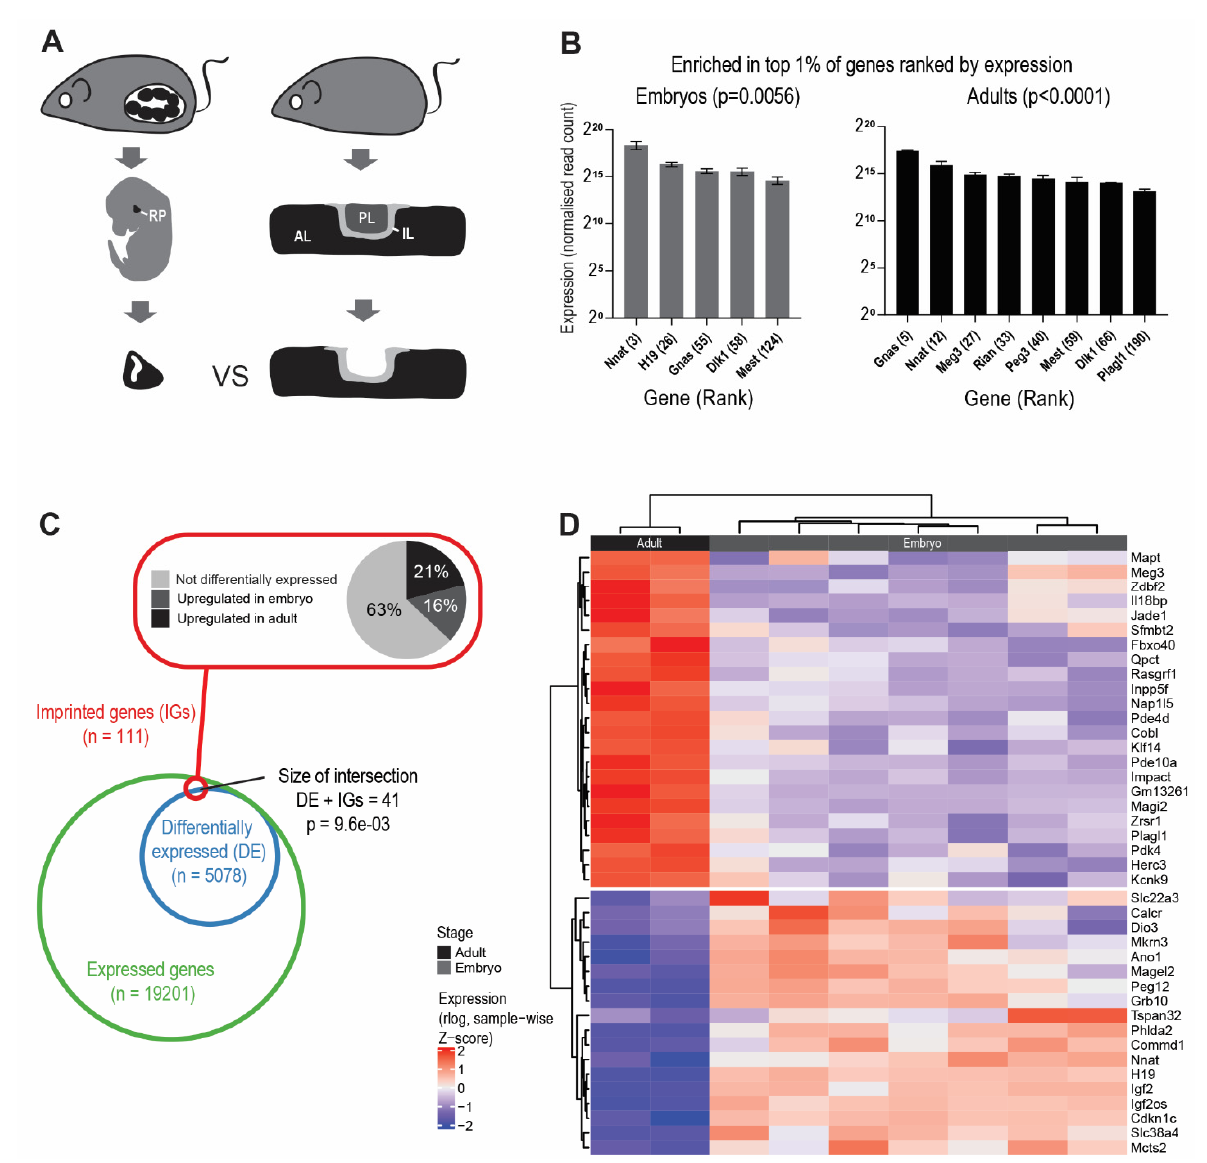
Figure 1. Imprinted genes are highly expressed in the anterior pituitary (AP) and are developmentally regulated. Schema of experimental design: for embryonic samples, Rathke’s pouch (RP) was microdissected from the embryonic heads at e13.5 ( n = 7), adult samples at 8 weeks ( n = 2) were dissected whole, then the posterior lobe (PL) was removed, leaving the anterior lobe (AL) and intermediate lobes (IL) for further analysis ( A ). We ranked genes according to mean normalised read count in the embryonic and adult pituitary samples. Imprinted genes at both ages were enriched in the top 1% of all expressed genes using Fisher’s exact test, and p -values are shown above the graphs ( B ). Venn diagram showing overlap of expressed imprinted genes (red) and differentially expressed genes (blue). The overlap was tested for statistical significance using Fisher’s exact test considering the list of expressed genes (green) as the background ( C ). Heatmap showing imprinted genes, which are differentially expressed between the embryo and adult samples ( D ). Statistical significance for differential expression between the embryo and adult samples was determined based on a p -value (corrected for multiple hypothesis testing based on the Benjamini–Hochberg procedure) threshold of 0.05 and a fold change threshold of 4. A regularised log transformation was applied to normalised counts (see Materials and Methods), and the values were then z-transformed across samples.